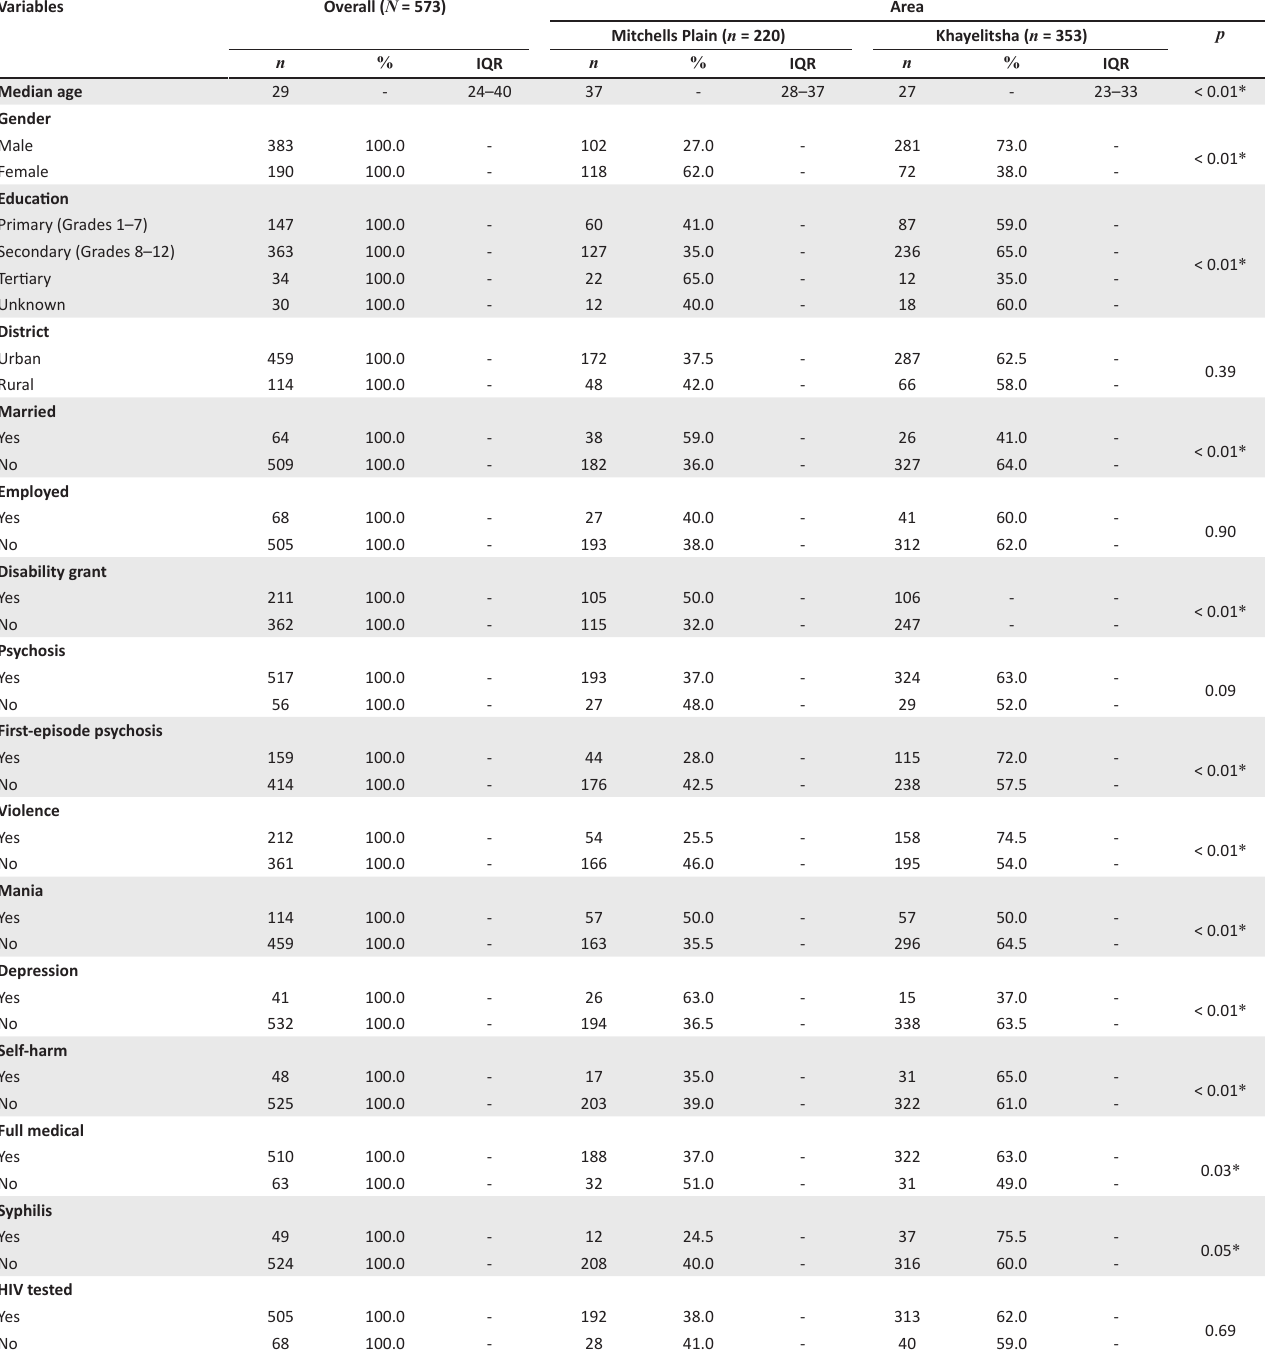
TABLE 4: Demographic and clinical characteristics of patients who used substances prior to admission. Variables